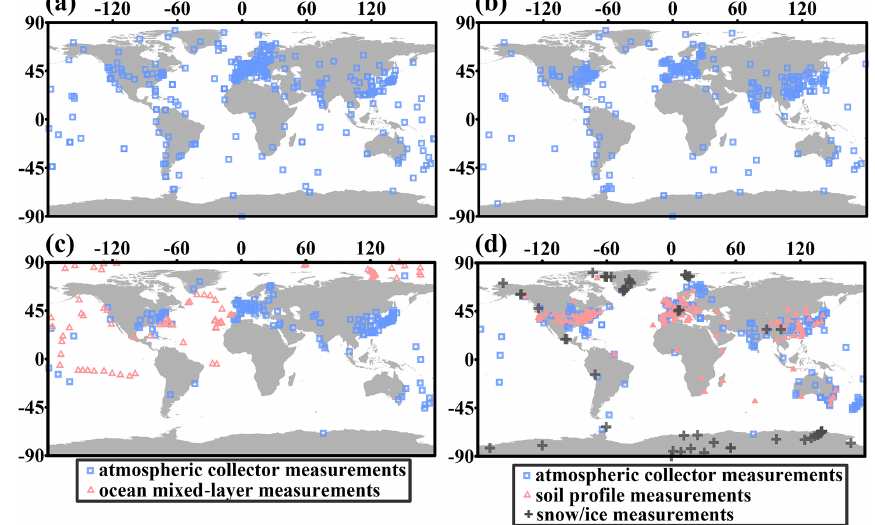
Figure 1. Maps showing sampling locations of (a) 7 Be concentration in surface air, (b) 210 Pb concentration in surface air, (c) 7 Be atmo- spheric depositional flux, and (d) 210 Pb atmospheric depositional